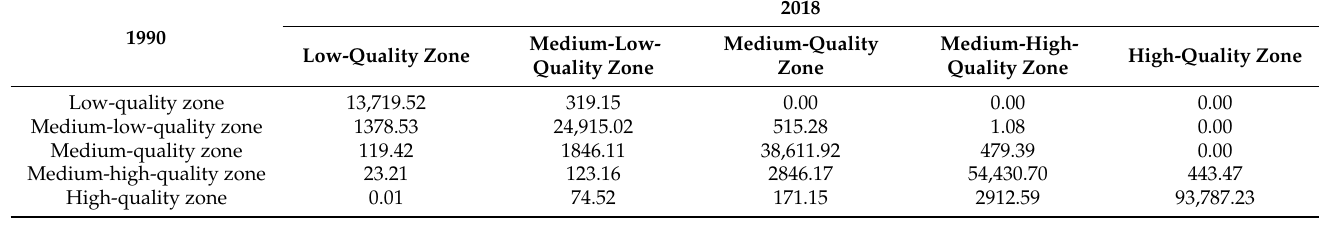
Table 5. Transfer matrix of eco-environmental quality zones during 1990–2018 (km 2 ).